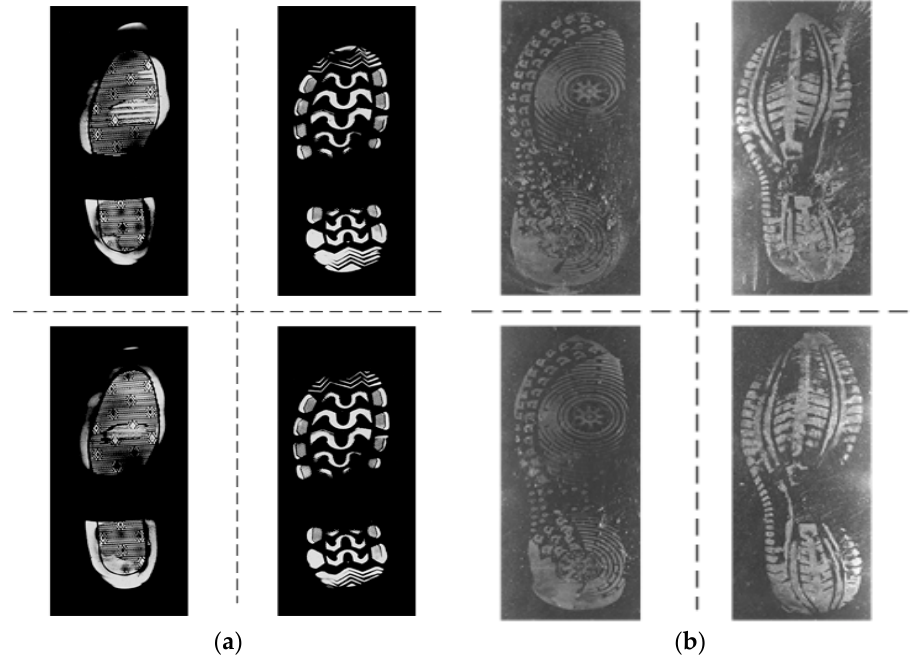
Figure 1. Sample of shoeprints in the datasets. ( a ) Samples of shoeprints in the MUES-SV1KR2R dataset; ( b ) Samples of shoeprints in the MUES-SV2HS2S dataset.